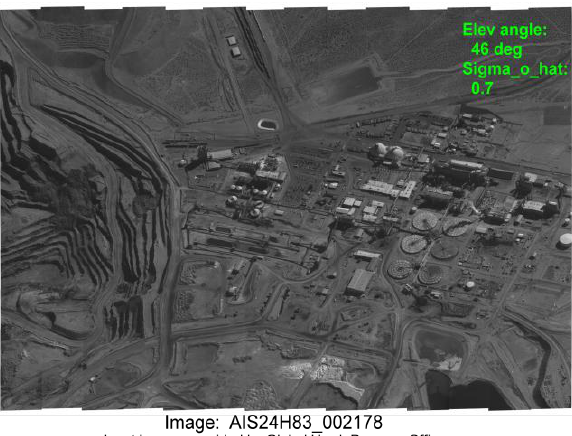
Figure 9. GH UAV output image product, Example 2